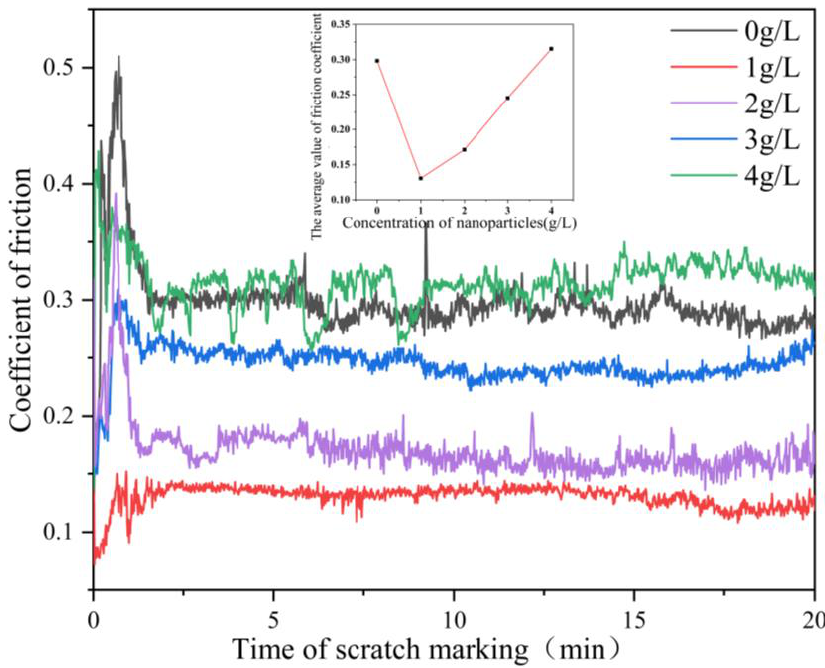
Figure 7. Relationship between the friction coefficient of the composite coating and the nanoparticle concentration.